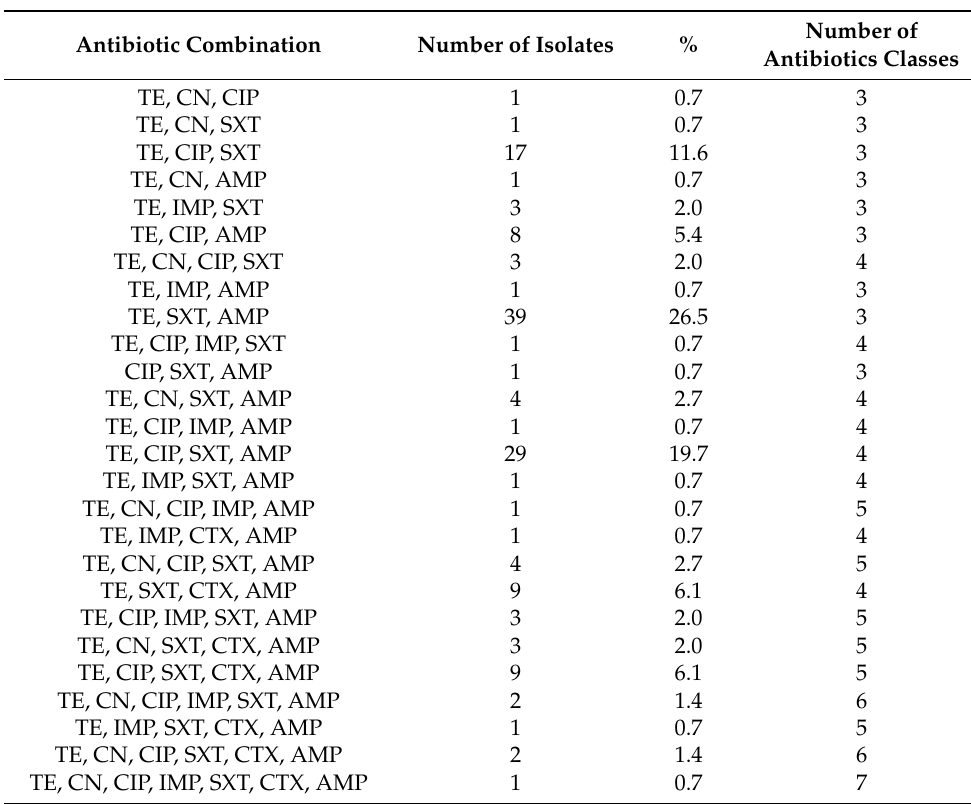
Table 3. Antimicrobial resistance pattern of multidrug-resistant E. coli.